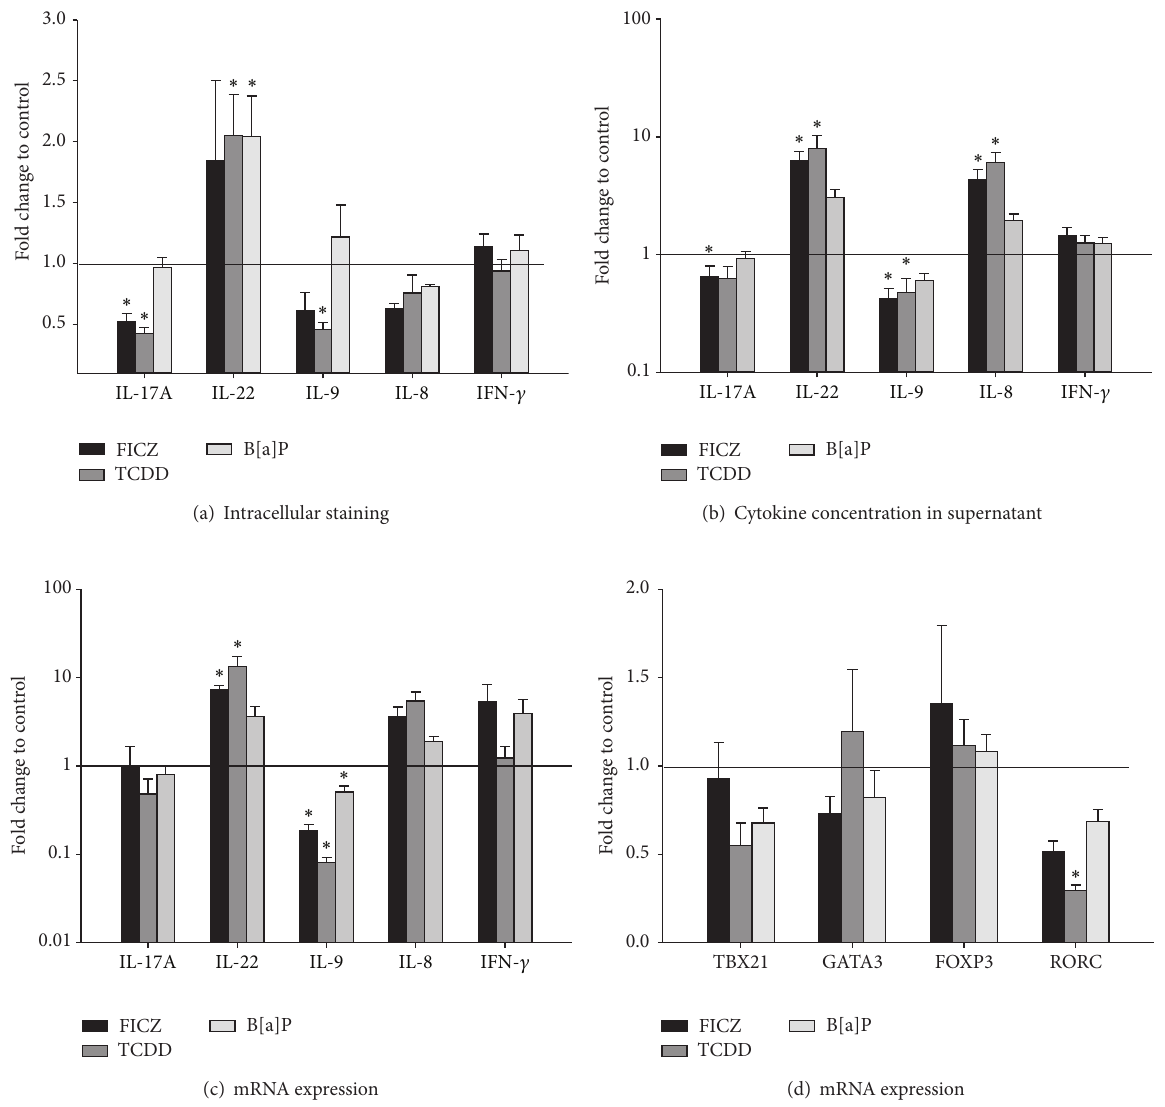
Figure 6: AHR ligands influence the cytokine expression of CD4 + T cells. CD4 + T cells were cultured with anti-CD3/anti-CD28, Th17 polar- izing conditions and the AHR ligands FICZ (100nM), TCDD (5 nM), and B[a]P (100nM) for five days. CD4 + T cells treated with anti- CD3/anti-CD28, Th17 polarizing conditions, and DMSO (0.05%) were used as control. (a) The amount of cytokine producing cells measured by intracellular staining is represented as fold change to control (black line) and shown as mean and SEM. ∗ represents significance, 𝑃 < 0.05 , Mann-Whitney 𝑈 test, and 𝑛 = 5 . (b) The concentration of secreted cytokines in the supernatant was measured by CBA (IL-17A, IL-9, IL-8, and IFN- 𝛾 ) and ELISA (IL-22). Data are shown as fold changes of cytokine concentration in the presence of AHR ligands compared to control (black line) and are represented as mean and SEM; ∗ represents significance, 𝑃 < 0.05 , Mann-Whitney 𝑈 test, and 𝑛 = 15 . (c) and (d) Relative mRNA expression of the indicated genes was measured by real-time PCR and data were normalized to the mean of GUSB, PPIA, and PGK1 and to the mRNA expression at day 0 using the ΔΔ Ct-method. The fold change of mRNA expression in AHR ligand treated cells compared to control (black line) is represented as mean and SEM; ∗ represents significance, 𝑃 < 0.05 , Mann-Whitney 𝑈 test, and 𝑛 = 7